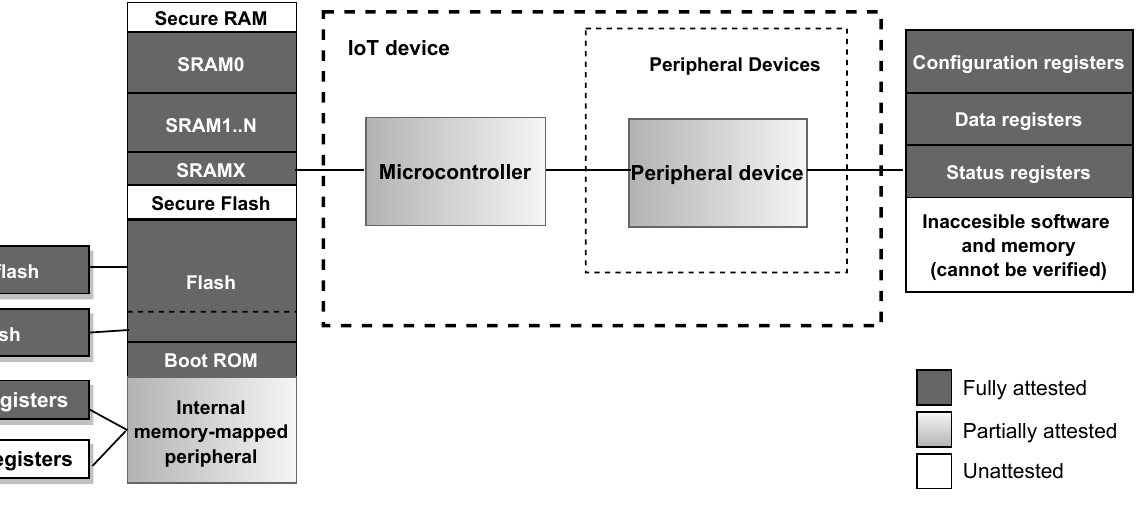
Figure 9. Memory regions attested by the ERAMO